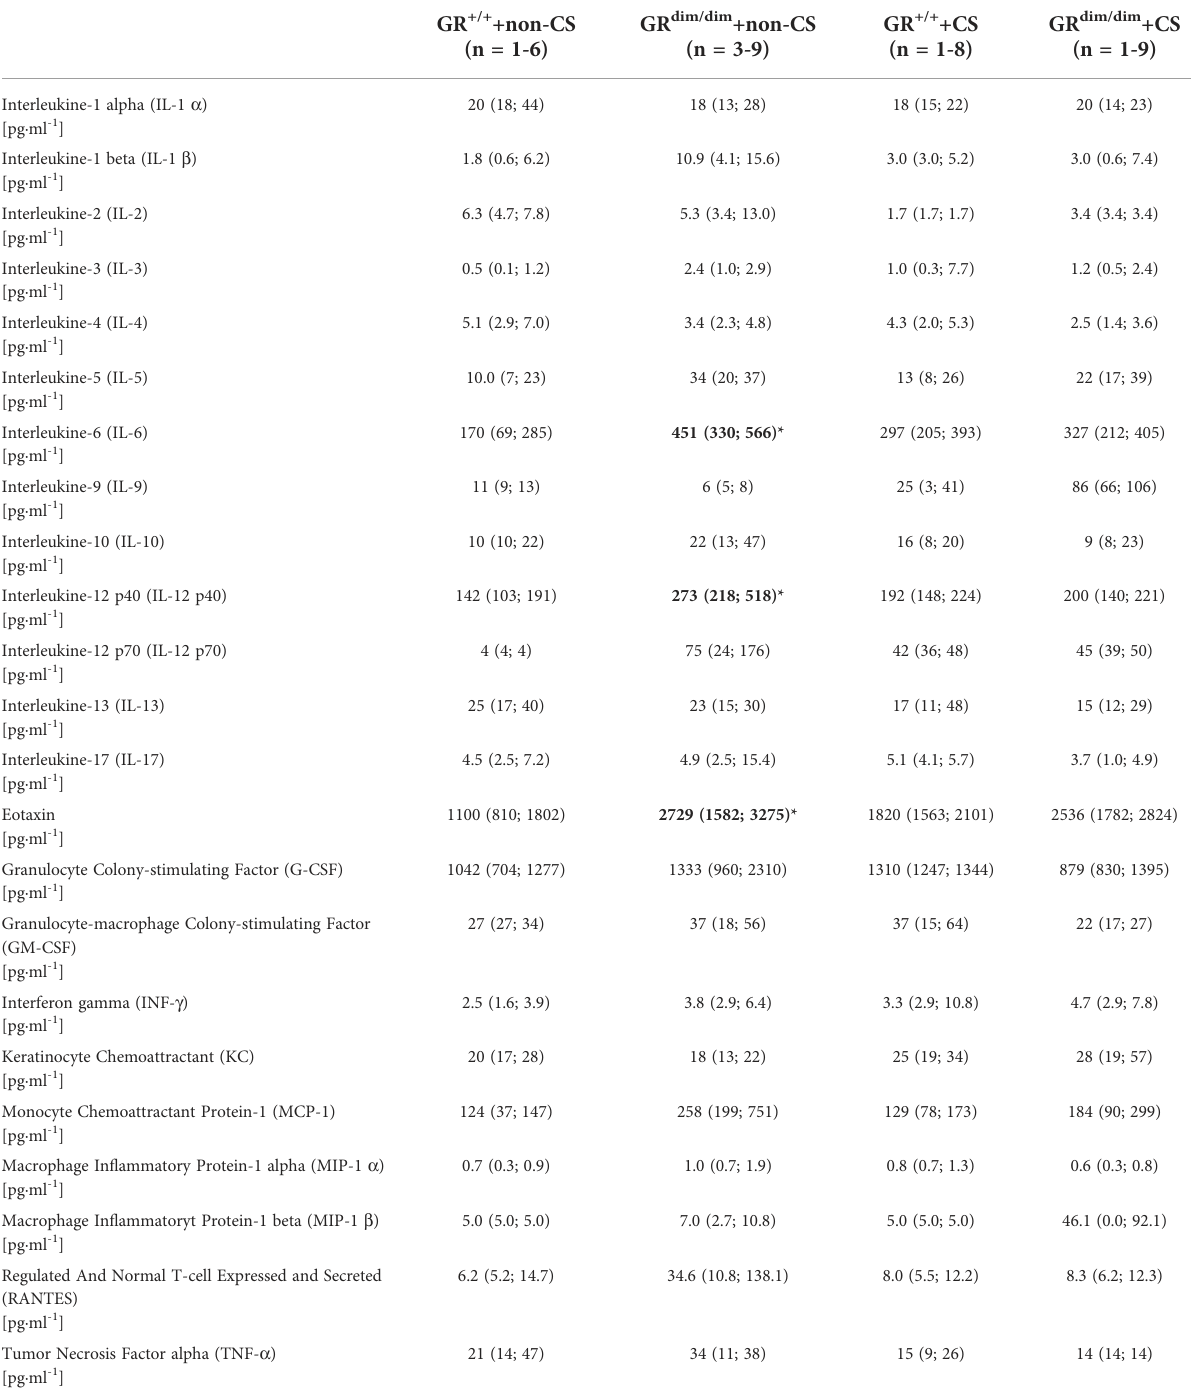
TABLE 2 Concentration of cytokines in plasma in GR dim/dim and GR +/+ mice with or without cigarette-smoke (CS) exposure and after HS with subsequent resuscitation (4 h) at the end of the experiment. Concentration of cytokines in plasma